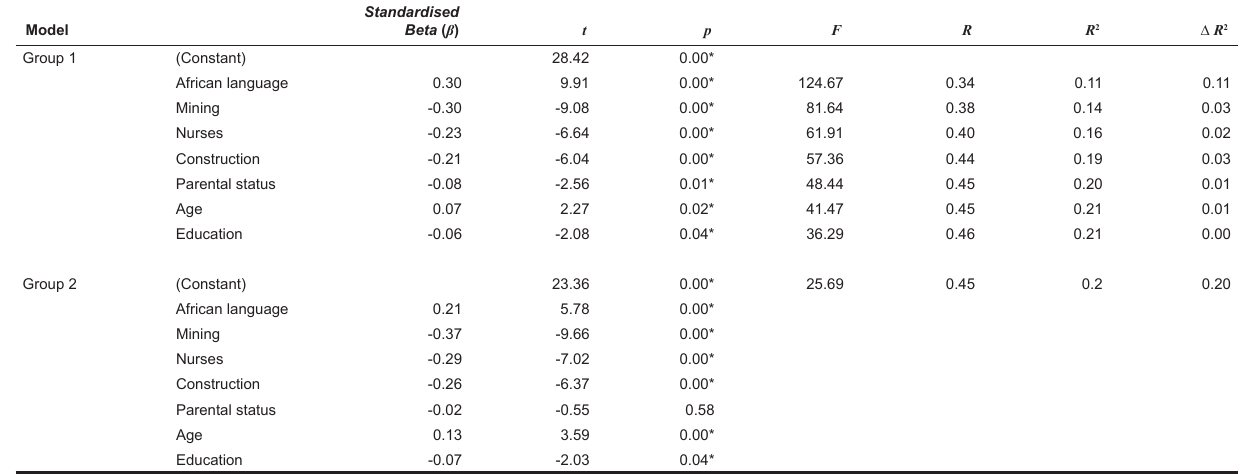
TABLE 5 Multiple regression analysis with positive HWI as dependent